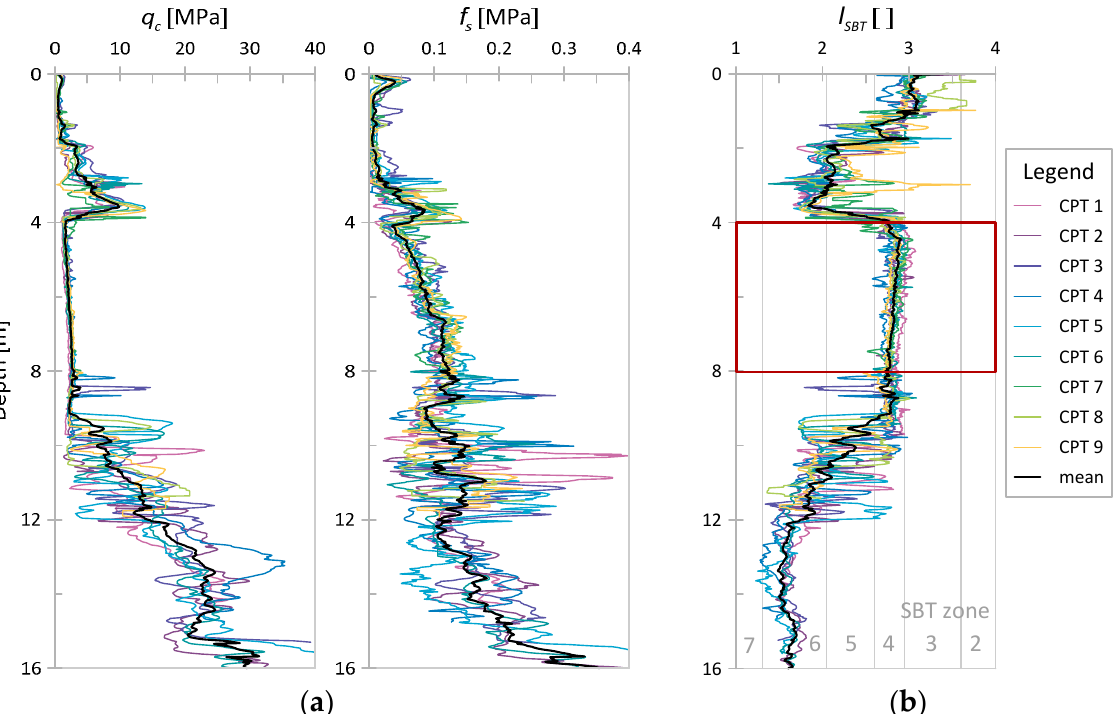
Figure 3. Results of nine CPTs from ´Swierzna [42]; ( a ) cone resistance q c and sleeve friction f s vs. depth; ( b ) nonnormalized SBT index ( I SBT ) vs. depth.